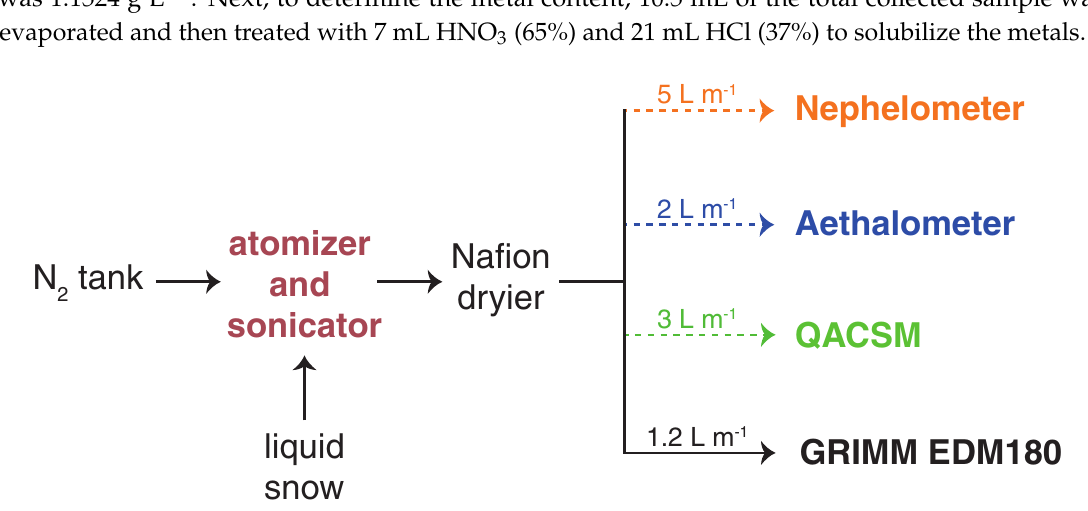
Figure 2. The experiment set-up for re-suspended dust